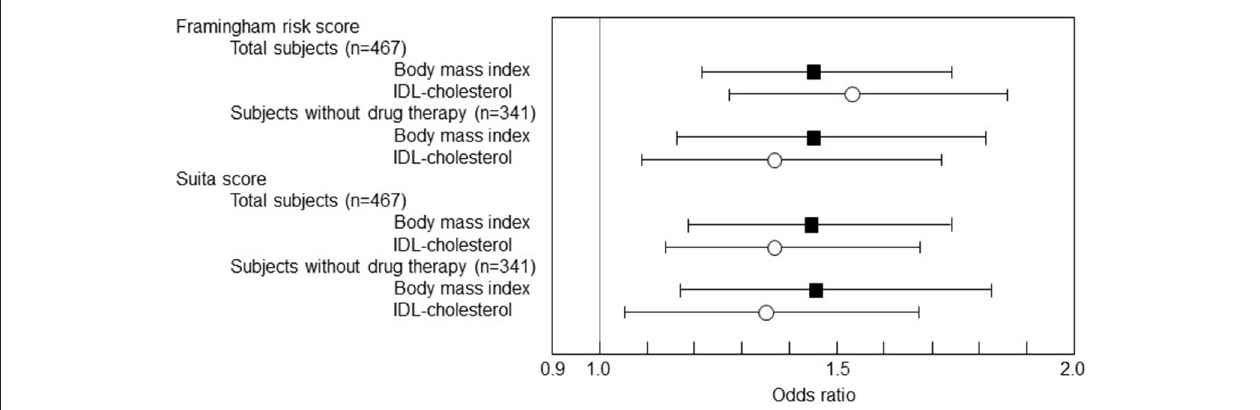
FIGURE 2 | The multivariate logistic regression analysis of BMI and cholesterol levels of IDL to F-score and S-score. The logistic regression results were shown as ORs and 95% CI s. The 1 SD increase in BMI was significantly associated with F-score 10-year CHD risk > 10% ( OR 1.448, 95% CI 1.206–1.738, p = 0.0001 in total subjects and OR 1.450, 95% CI 1.163-1.808, p < 0.0001 in the subjects without drug therapy). The 1 SD increase in BMI was also associated with S-score 10-year CHD risk > 10% ( OR 1.441, 95% CI 1.194–1.739, p = 0.0001 in total subjects and OR 1.462, 95% CI 1.173–1.823, p = 0.0007 in the subjects without drug therapy). Besides, the 1 SD increase in IDL-C was associated with F-score 10-year CHD risk > 10% ( OR 1.534, 95% CI 1.266–1.859, p < 0.0001 in total subjects and OR 1.368, 95% CI 1.091–1.716, p = 0.0066 in the subjects without drug therapy) and also associated with S-score 10-year CHD risk > 10% ( OR 1.372, 95%